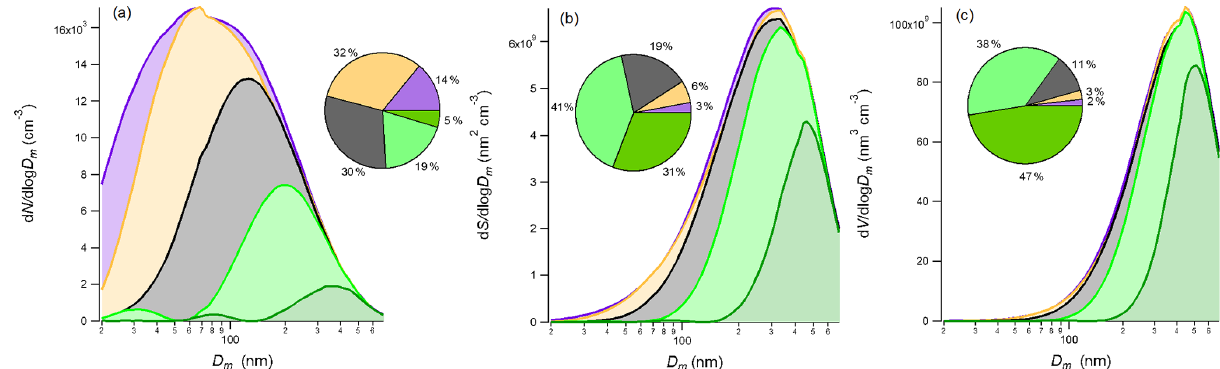
Figure 10. Profiles and fractions of (a) number, (b) surface area (c) and volume distributions from size PMF analysis. Traffic-ultrafine denotes the ultrafine particles related to traffic emissions (purple range), traffic-fine denotes the fine particles related to traffic emissions (black range) and cooking rel denotes the particles related to cooking activities (yellow range). Reg 1 and reg 2 denote the particles related to regional sources type 1 (light green range) and 2 (dark green range),